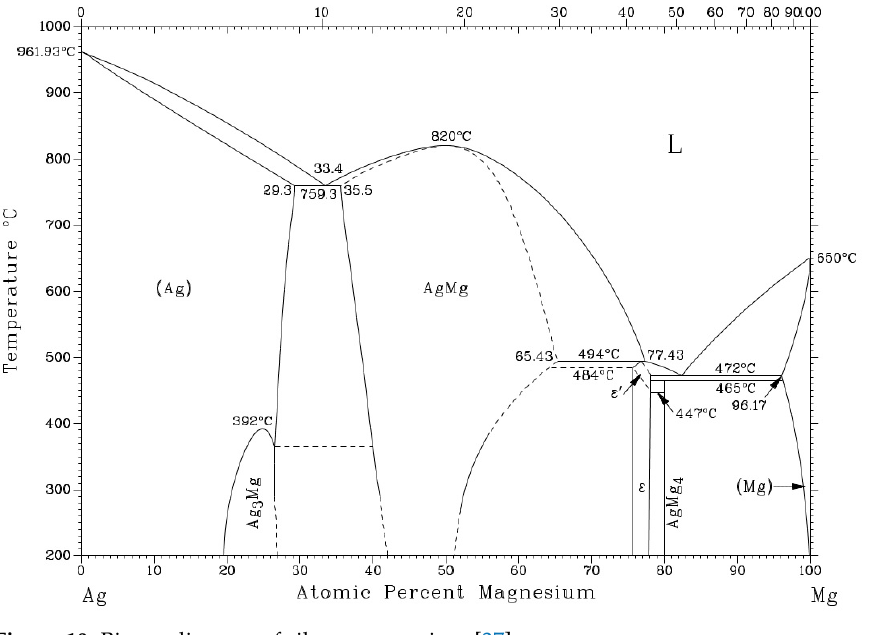
Figure 10. Binary diagram of silver–magnesium [37].